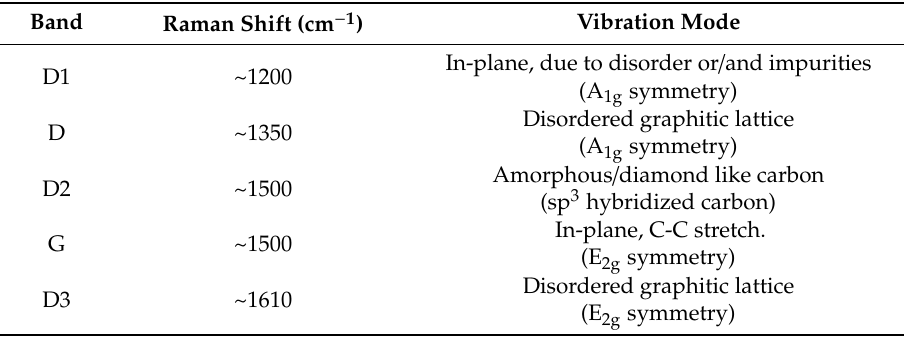
Table 2. First-order Raman bands and vibrational modes.